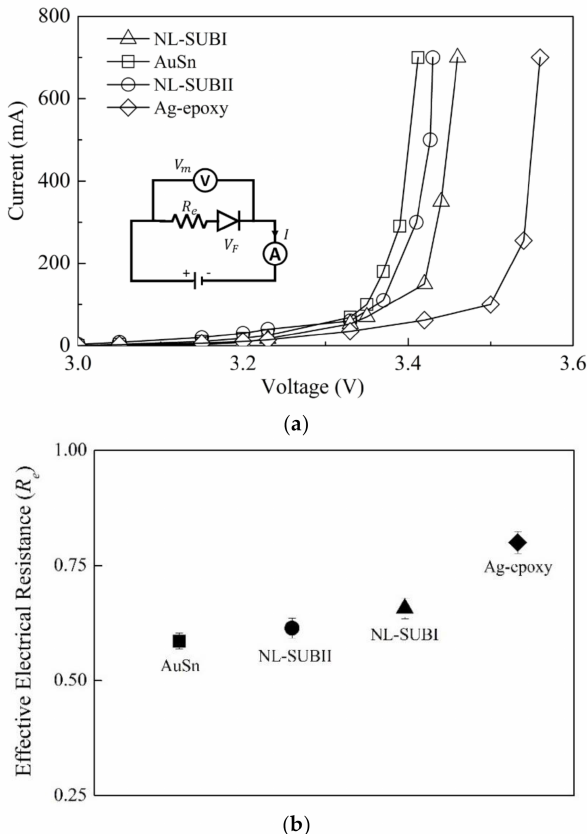
Figure 6. ( a ) Measurement of the current (I) and voltage (V) relationship for the devices made of the present NL with different substrates and conventional die–substrate interconnection and bonding methods. The open square symbol ( (cid:3) ) represents the AuSn bonding; the open circle symbol ( ) (cid:35) represents the NL bonding with substrate type-II; the open triangle symbol ( (cid:52) ) represents the NL bonding with substrate type-I; the open rhombus symbol ( ) represents the Ag-epoxy bonding. The (cid:51) solid curve represents the best I-V fitting. ( b ) The R e of packaged devices made by NL bonding with different substrates and different die–substrate interconnection and bonding methods: the solid square symbol ( (cid:4) ) represents AuSn bonding with an industrial standard BLT value of 20 ± 2 µ m; the solid circle symbol ( • ) represents the NL bonding with substrate type-II; the solid triangle symbol ( (cid:78) ) represents the NL bonding with substrate type-I; the solid rhombus symbol ( (cid:117) ) represents the Ag-epoxy bonding with an industrial standard BLT value of 25 ± 2 µ